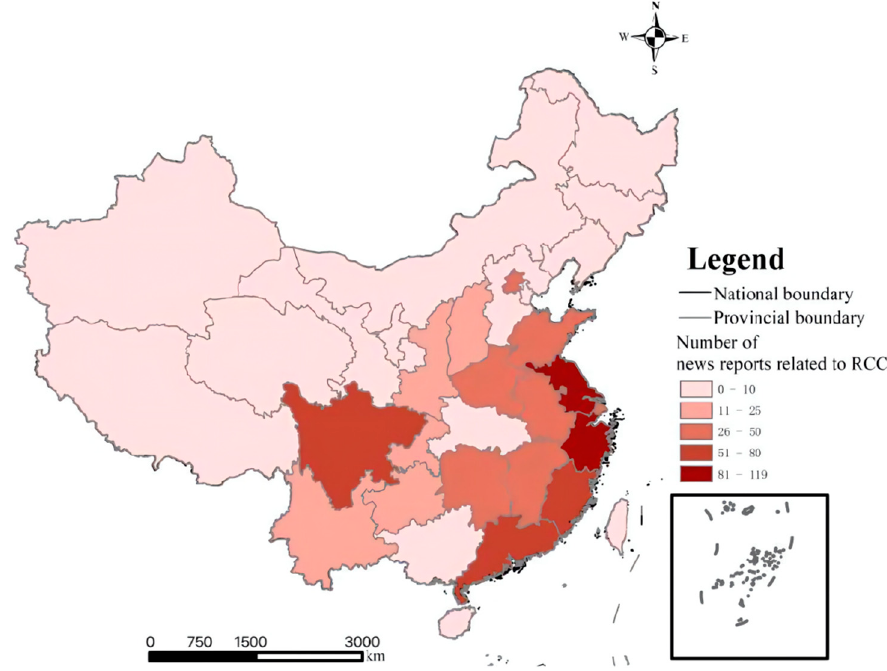
Figure 3. The distribution of RCCs in China.